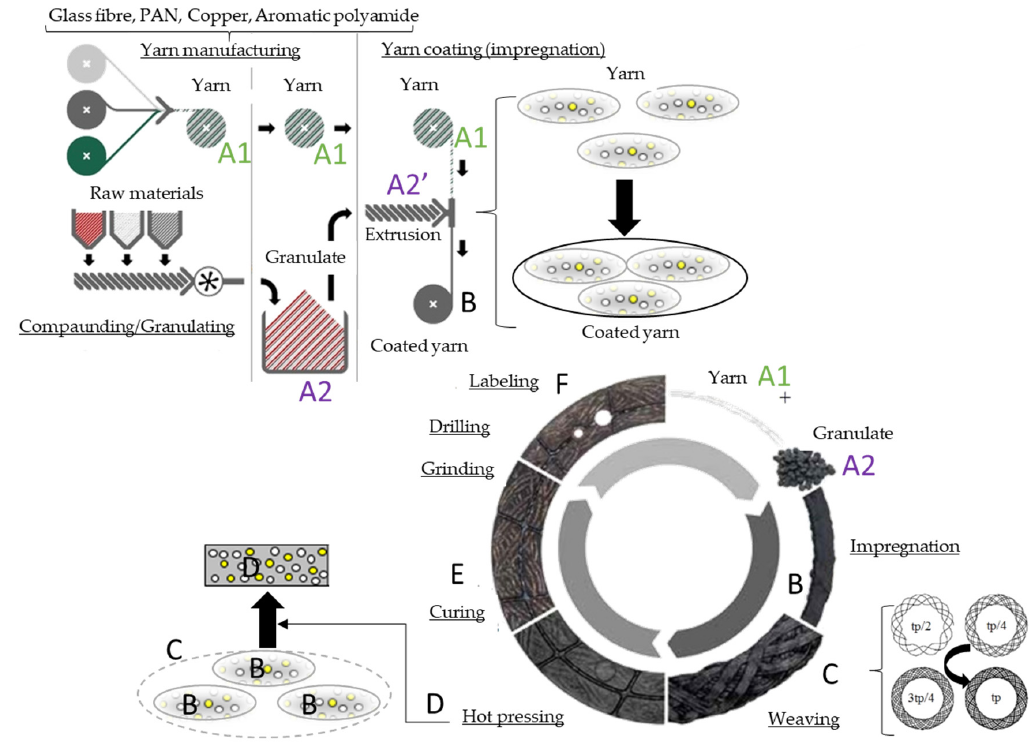
Figure 7. Production steps of the hybrid composite conventional dry-friction clutch facing.